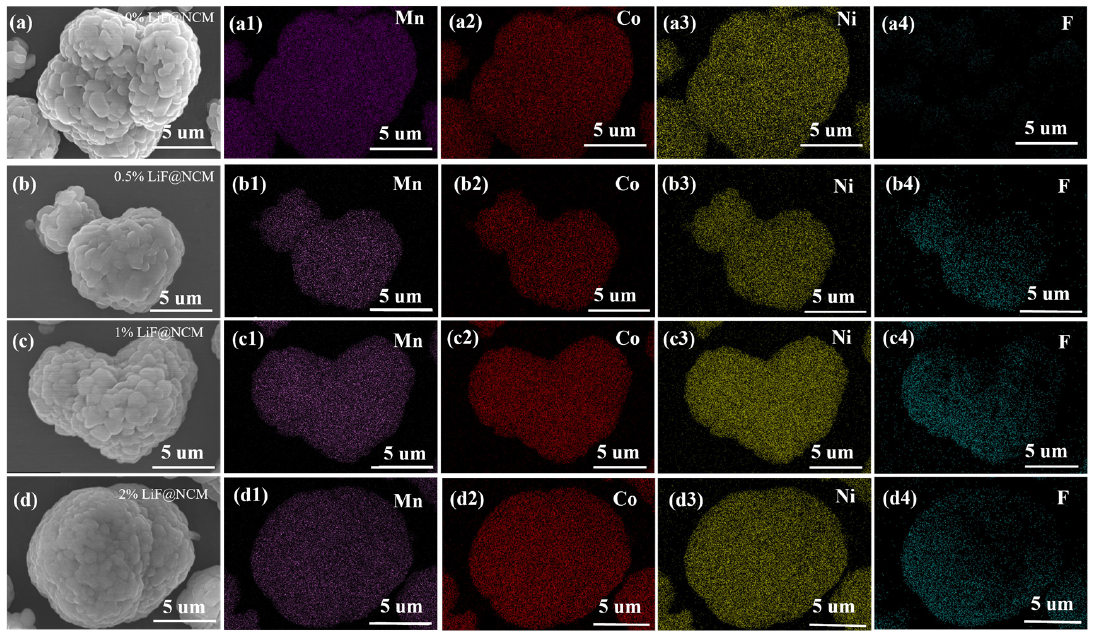
Figure 4. Elemental mapping images of ( a ) 0%LiF@NCM(( a1 ) Mn, ( a2 ) Co, ( a3 ) Ni, ( a4 ) F), ( b ) 0.5%LiF@NCM (( b1 ) Mn, ( b2 ) Co, ( b3 ) Ni, ( b4 ) F), ( c ) 1%LiF@NCM (( c1 ) Mn, ( c2 ) Co, ( c3 ) Ni, ( c4 ) F), and ( d ) 2%LiF@NCM (( d1 ) Mn, ( d2 ) Co, ( d3 ) Ni, ( d4 ) F).